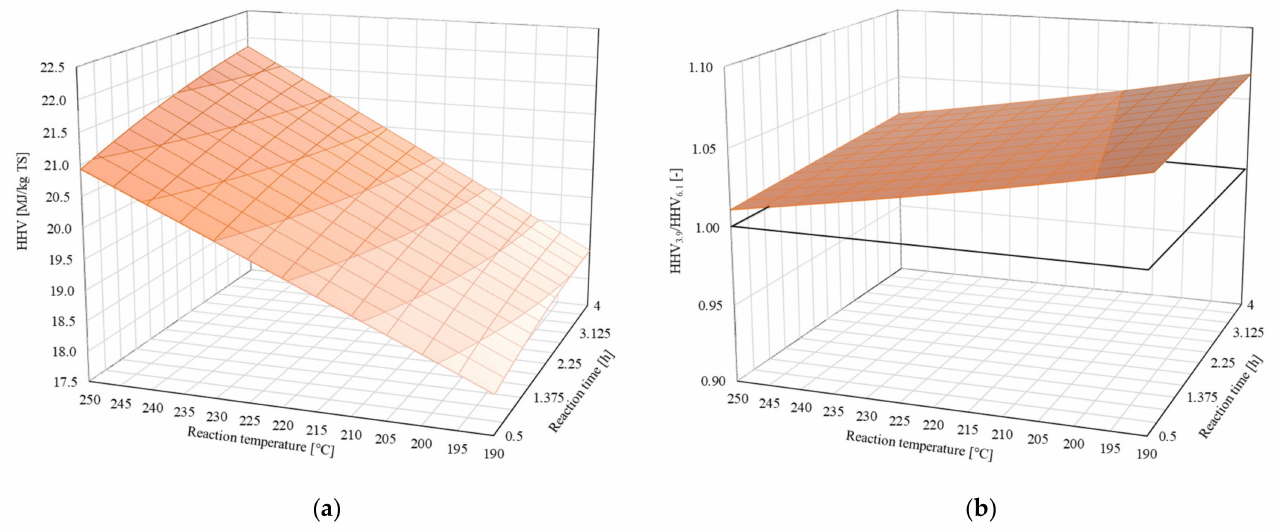
Figure 1. Response surface plots of ( a ) the HHV at pH = 6.1 and ( b ) the effect of different pH values on the